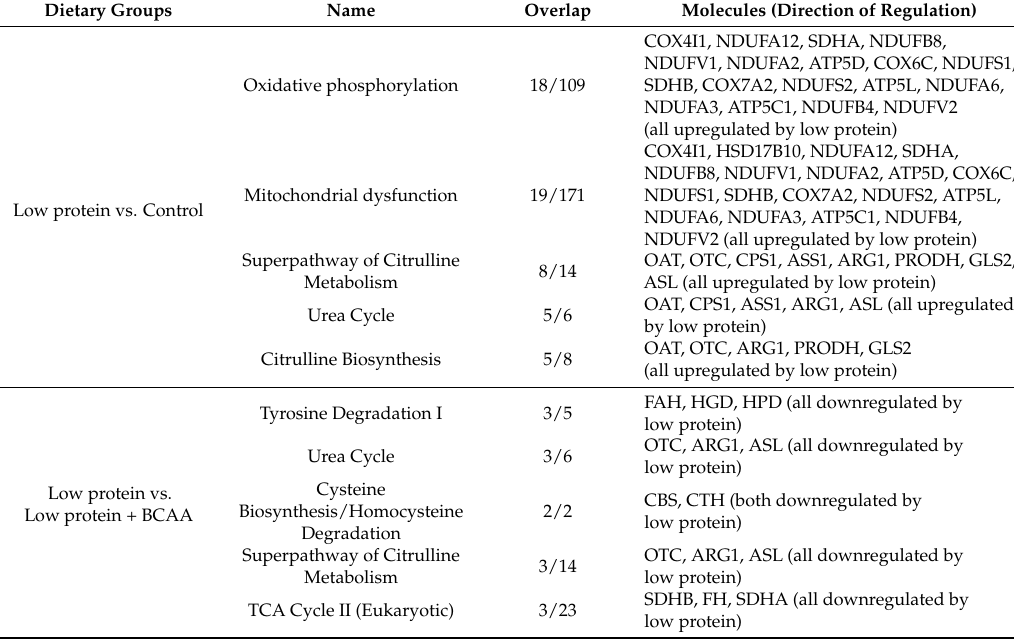
Table 4. Top canonical pathways identified in liver proteomics